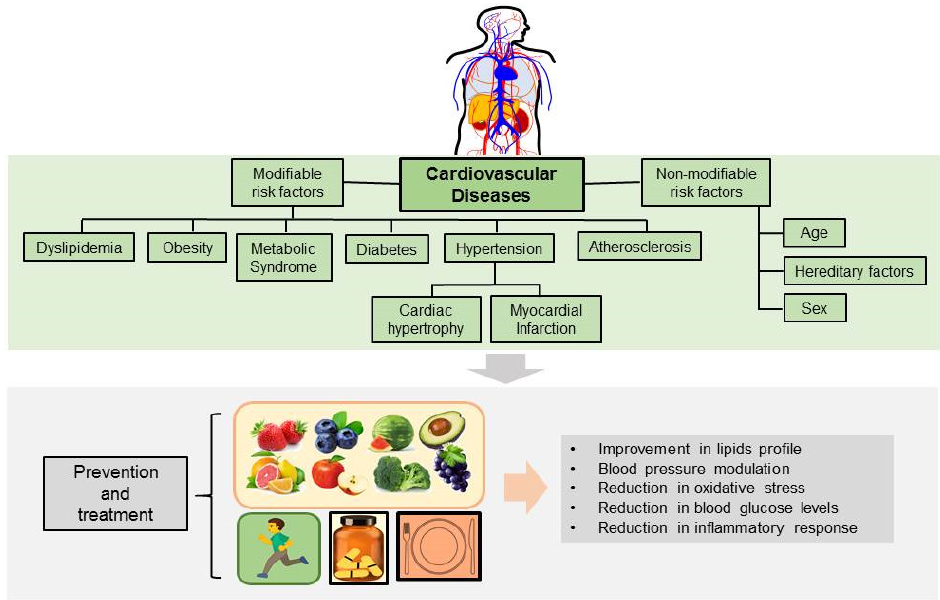
Figure 1. Cardiovascular diseases: classification of risk factors, physiological effects and strategies for prevention and treatment.